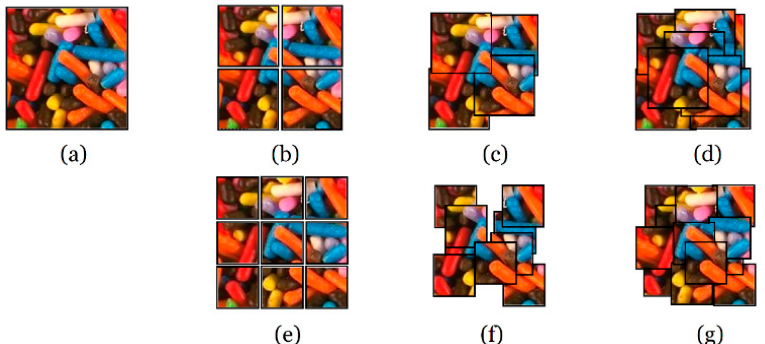
Figure 3. ( a ) A sample image from Vistex (Food0007) and the subdivision process. ( b , e ) Image is divided into n 2 images. ( c , f ) Image is divided into n 2 random blocks. ( d , g ) Image is divided into r × n 2 random blocks. In this example, ( b – d ) n = 2, ( e – g ) n = 3, and r = 2 ( d , g ).